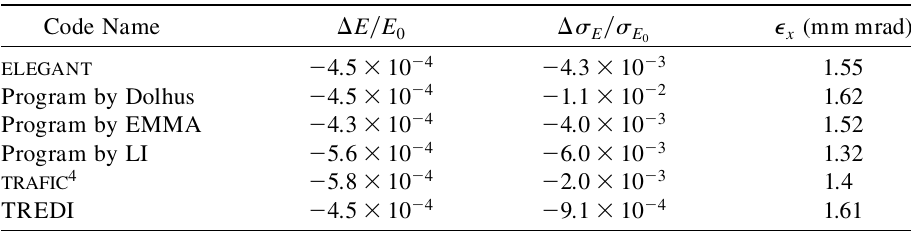
TABLE IV. Beam parameters at the end of the chicane for several different codes [19]. The ) refers to beam relative energy loss at the end of the chicane, while the second column ( (cid:30) E=E 0 =(cid:30) ) and fourth ( 3 ) columns refer to the variation of the relative rms energy third ( (cid:30) (cid:30) E E 0 x spread and the final emittance, respectively.